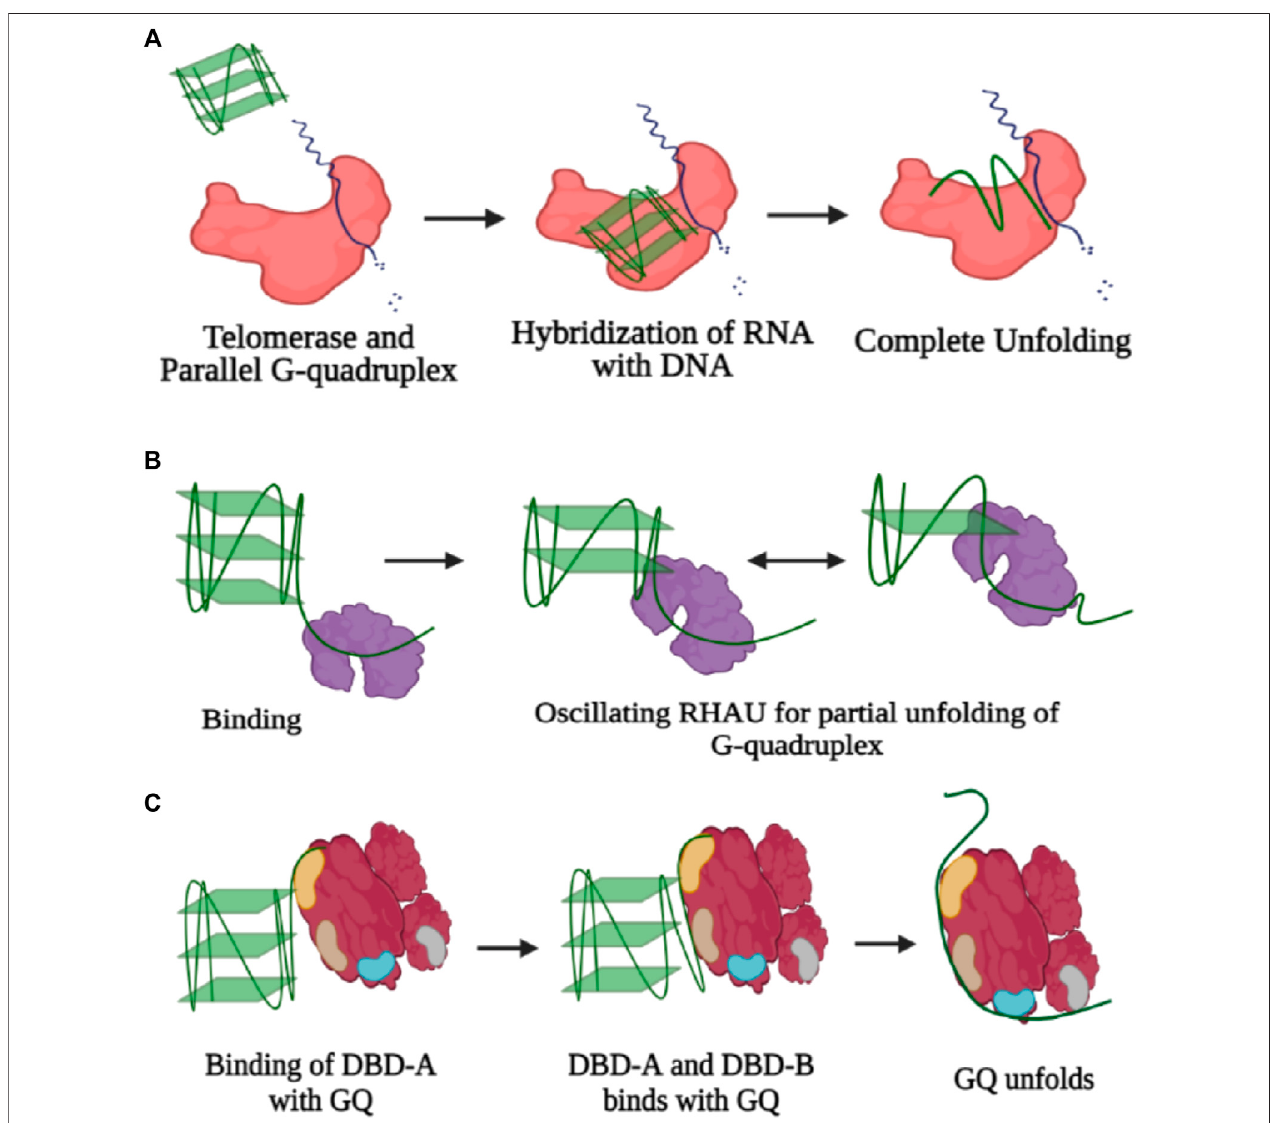
FIGURE 5 | (A) Three-step unfolding of the parallel G-quadruplex by telomerase enzyme (colored in red). Initially, there is recognition and binding of GQ with telomerase, followed by partial unfolding via complementary binding of the RNA template with the G-quadruplex substrate. The 3 ′ -end of the partial unwound GQ structure is extended by addition of single nucleotides, and eventually, there is complete disruption ofthe GQ structure. (B) Resolution of GQ by RHAU (colored in blue). Bindingof RHAU occurs inthe 3 ′ overhang, and further motilityof the protein causes repetitive unfolding and refolding. (C) GQ unfolding by RPA. Initial recognition is through DBD-A and further contacts are established with DBD-B, followed by complete unfolding of the GQ structure through formation of contacts with other DBDs (created with BioRender.com).